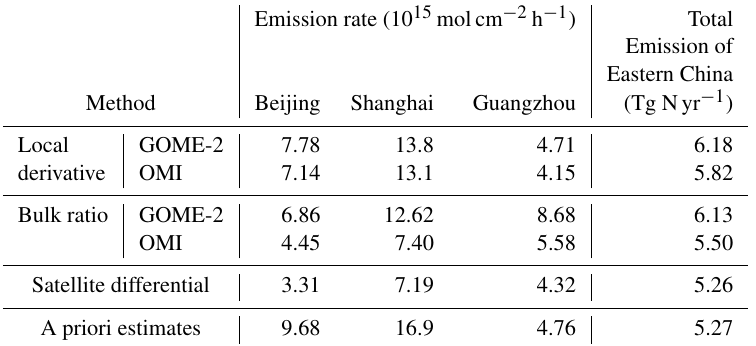
Figure 3. Relative difference of inversion emission estimates for NO x with GOME-2 relative to OMI products using the local derivative and the bulk ratio methods: regional distributions over eastern China for August 2007 (left) and the differences in three megacities (right). Table 1. NO x inversion emission estimates for August 2007 using the local derivative, bulk ratio and satellite differential inversion